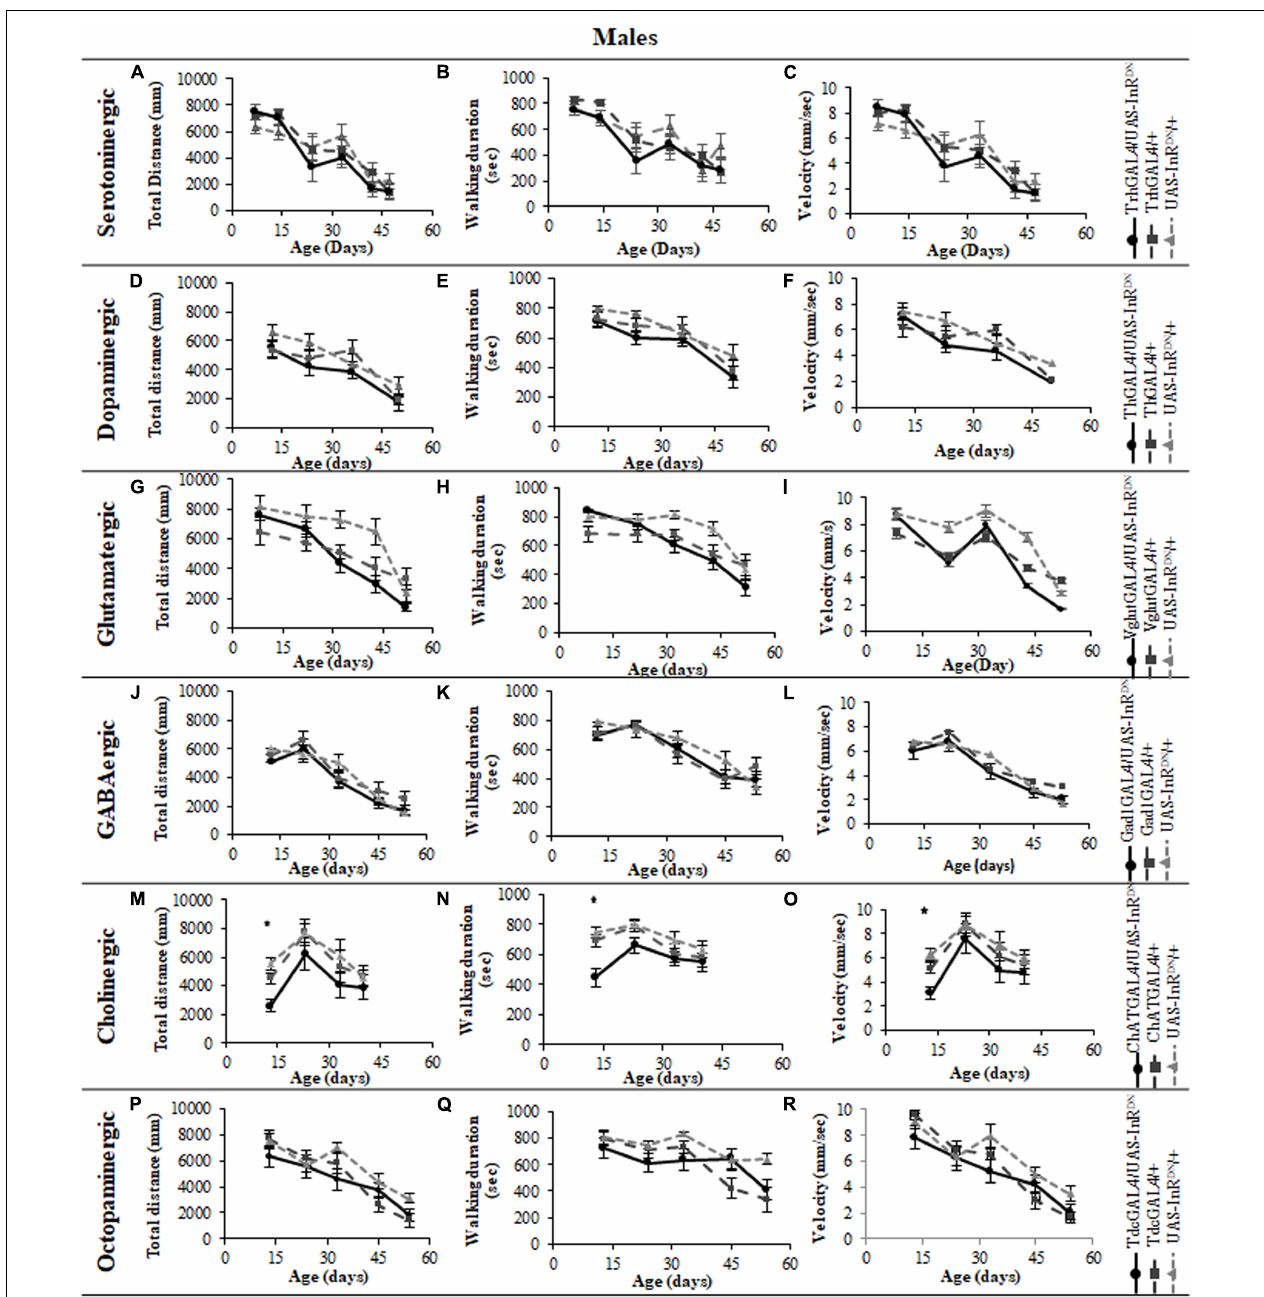
FIGURE 6 | The effect of neuronal subtype specific IIS reduction on decision making during exploratory walking senescence in male flies. Exploratory walking senescence parameters for a cohort of male flies of the indicated genotypes run in parallel with the survival experiments shown in Figure 1 . Data are shown as mean value for each parameter ± SEM, N = 16 for the indicated genotype. Data were analyzed by two-way ANOVA (age and genotype) and age was found to be a significant effect ( p < 0.05) for all genotypes. (A) Mean duration flies spent in the central zone vs. age of TrhGAL4/UAS-InR DN flies compared to TrhGAL4/ + and UAS-InR DN / + controls. (B) Mean latency to first rotation vs. age of TrhGAL4/UAS-InR DN flies compared to TrhGAL4/ + and UAS-InR DN / + controls. (C) Mean rotation frequency vs. age of TrhGAL4/UAS-InR DN flies compared to TrhGAL4/ + and UAS-InR DN / + controls. (D) Mean duration flies spent in the central zone vs. age of ThGAL4/UAS-InR DN flies compared to ThGAL4/ + and UAS-InR DN / + controls. (E) Mean latency to first rotation vs. age of ThGAL4/UAS-InR DN flies compared to ThGAL4/ + and UAS-InR DN / + controls. (F) Mean rotation frequency vs. age of ThGAL4/UAS-InR DN flies compared to ThGAL4/ + and UAS-InR DN / + controls. (G) Mean duration flies spent in the central zone vs. age of VglutGAL4/UAS-InR DN flies compared to VglutGAL4/ + and UAS-InR DN / + controls. (H) Mean latency to first rotation vs. age of VglutGAL4/UAS-InR DN flies compared to VglutGAL4/ + and UAS-InR DN / + controls. (I) Mean rotation frequency vs. age of VglutGAL4/UAS-InR DN flies compared to VglutGAL4/ + and UAS-InR DN / + controls. (J) Mean duration flies spent in the central zone vs. age of Gad1GAL4/UAS-InR DN flies compared to Gad1GAL4/ + and UAS-InR DN / + controls. (K) Mean latency to first rotation vs. age of Gad1GAL4/UAS-InR DN